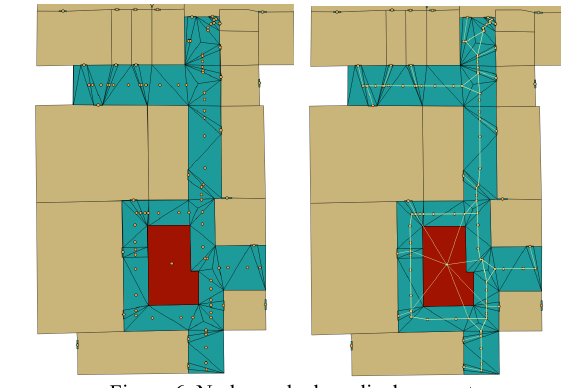
Figure 6. Nodes and edges displacement